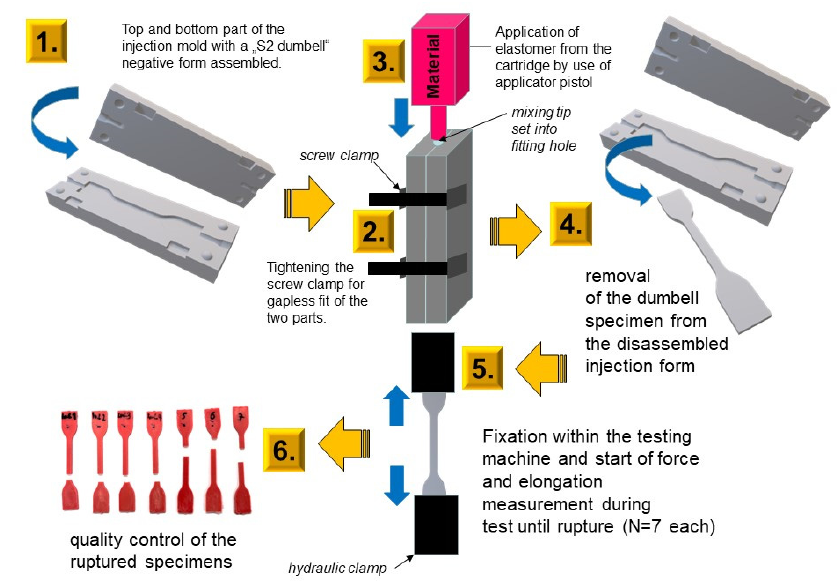
Figure 5. Specimen preparation and testing of the tear strength.